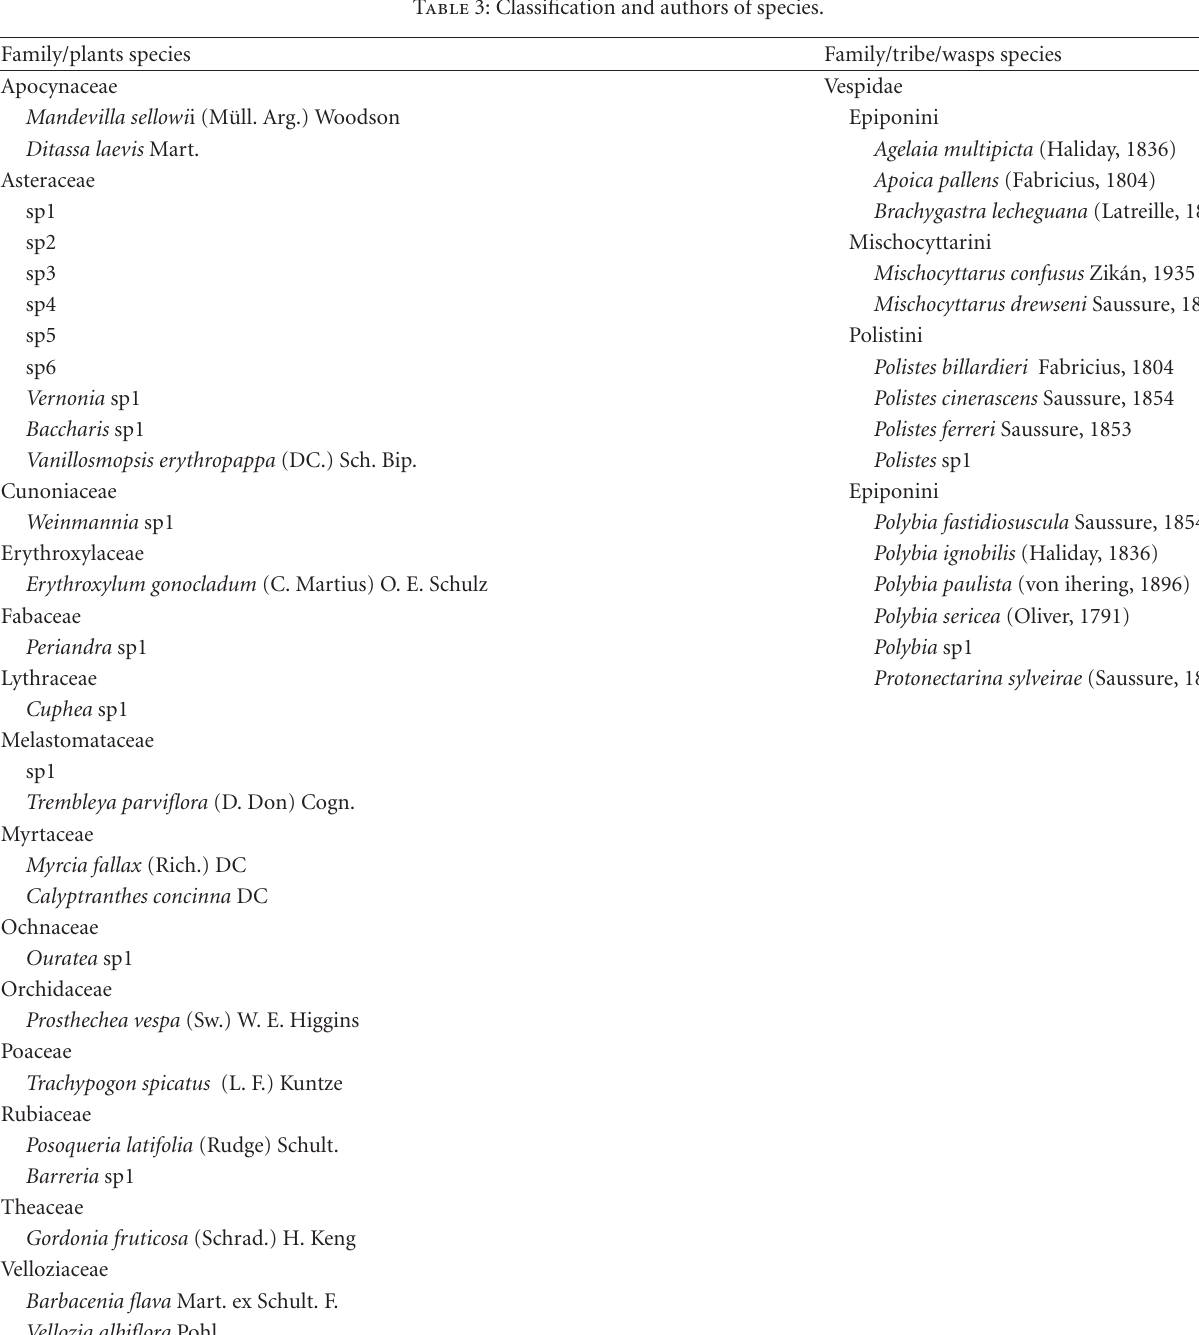
Table 3: Classification and authors of